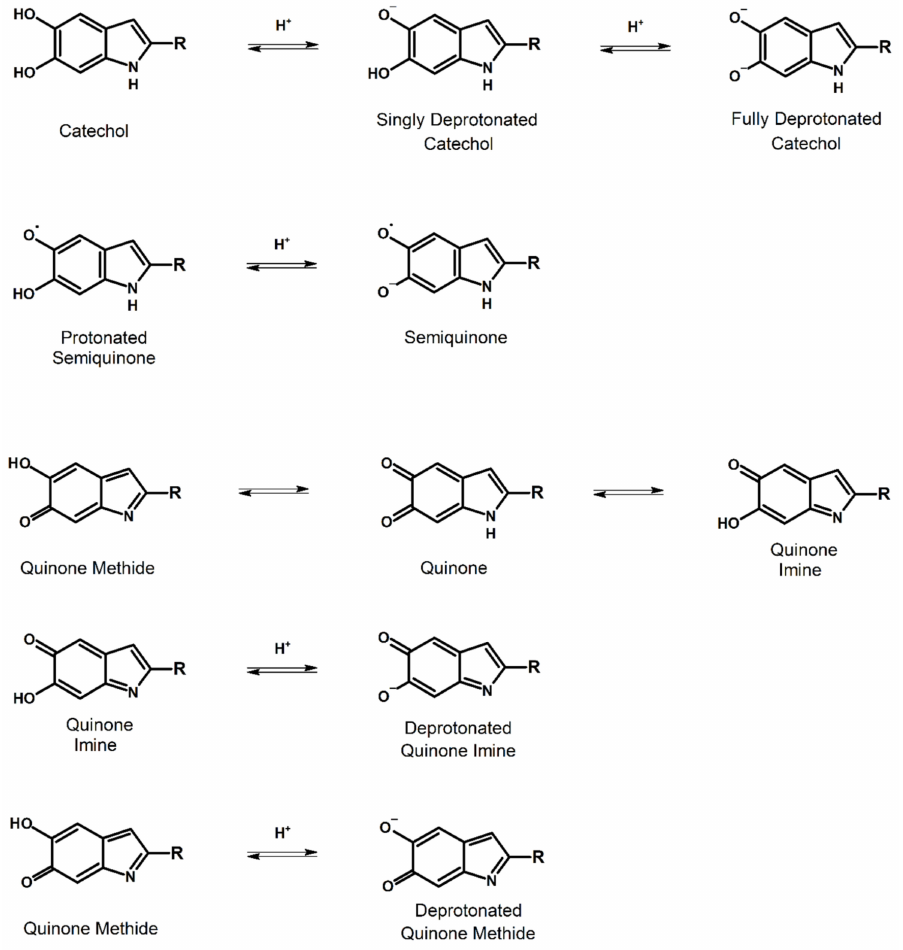
Figure 1. The starting monomers of melanin and their various redox states and tautomers including their deprotonated states. (i) For the catechol where R = H, one has a 5,6-dihydroxyindole (DHI). For R = COOH one obtains a 5,6-dihydroxyindole-2-carboxylic acid (DHICA). These two molecules are the primary starting monomers for melanin synthesis. This figure was adapted from Chemical Physics, 546, A.B. Mostert, On the free radical redox chemistry of 5,6-dihydroxyindole, 111158, Copyright Elsevier (2021)